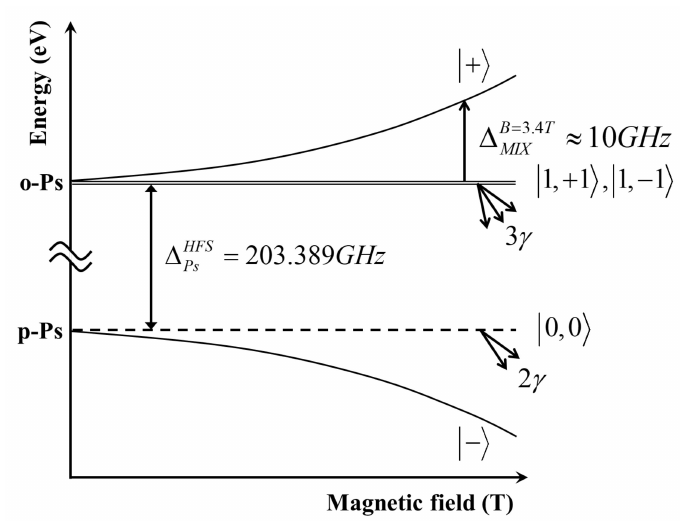
Figure 5. The splitting of Ps energy-levels under Zeeman effect.